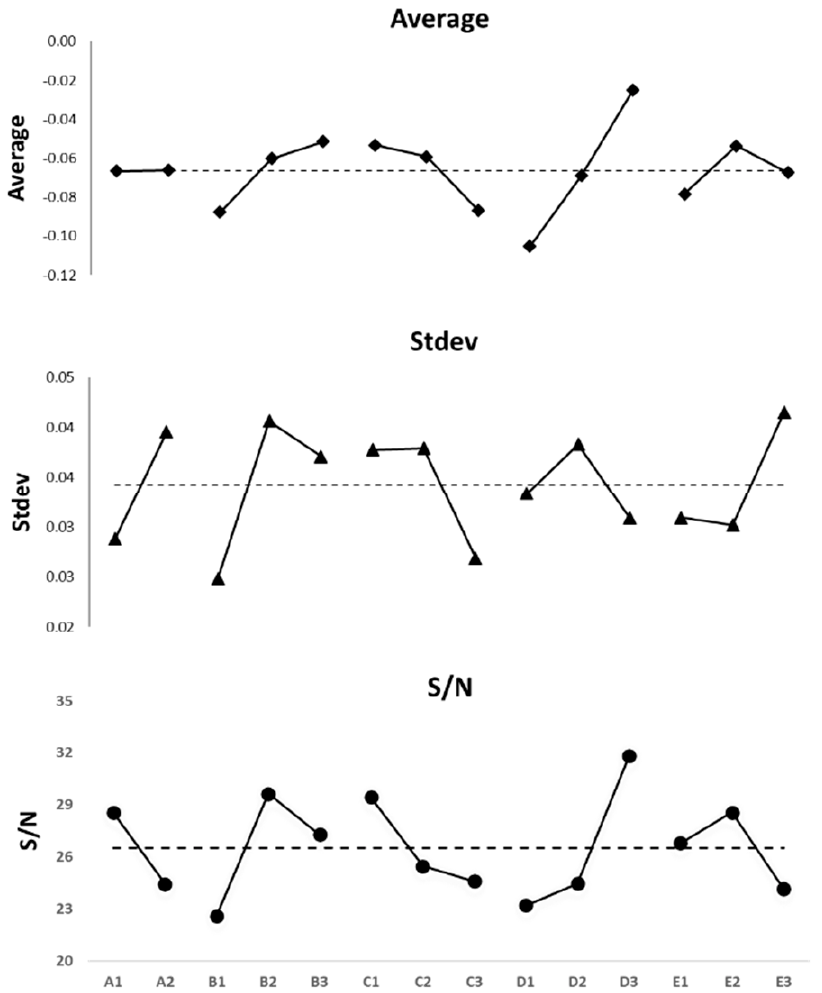
Figure 4. The fish-bone plot according to the diameter difference between the theoretical preset and practical measurement. A significant difference between the area- and diameter-based results shows a fluctuating outcome according to two difference scenarios. Table 6. The evaluation results obtained from three independent measurements via Equation (6). The diameter difference is defined as the difference between the practical survey and the theoretical survey (0.8 cm).